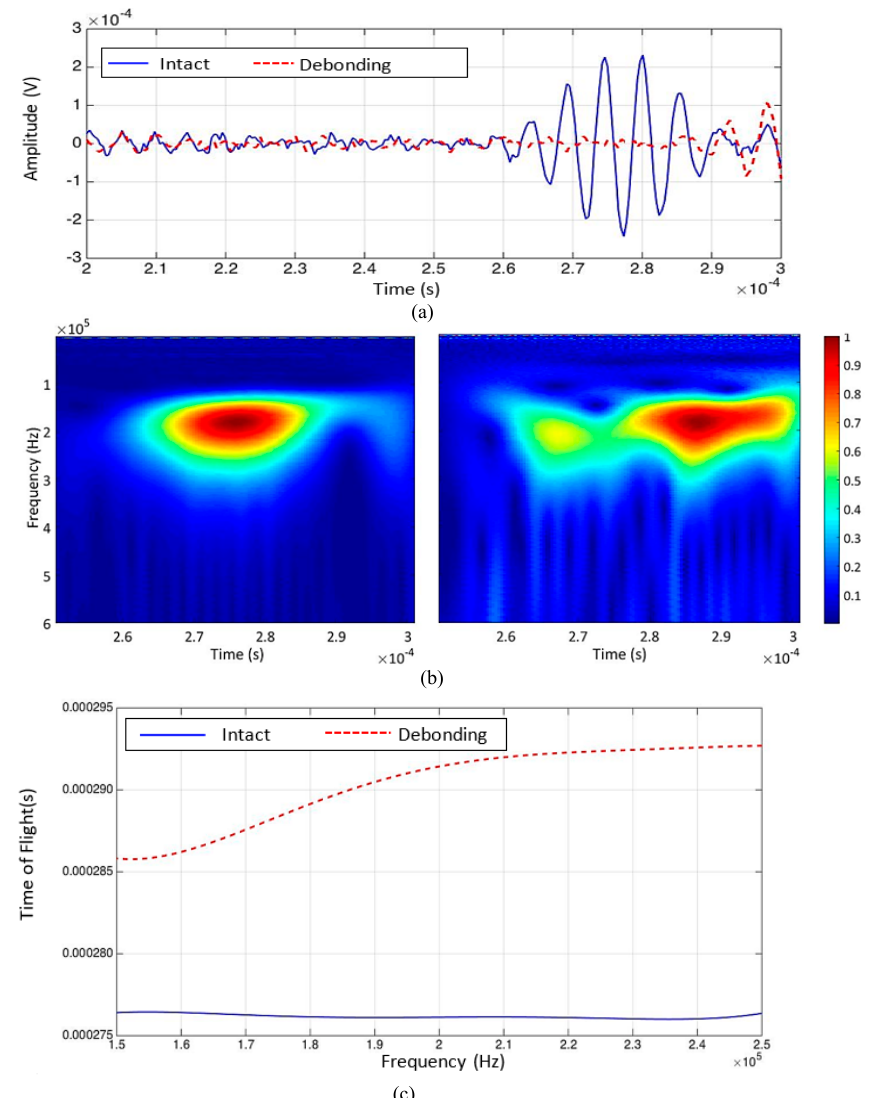
Figure 8. Experimental results: ( a ) two representative signals obtained from intact bonding (blue solid line) and weakened bonding (red dashed line) conditions in the time domain; ( b ) two representative signals obtained from intact (left) and debonding (right) conditions in the time-frequency domain; ( c ) extraction of time of flights (TOFs) from intact (blue solid line) and debonding (red dashed line) conditions within the frequency range of